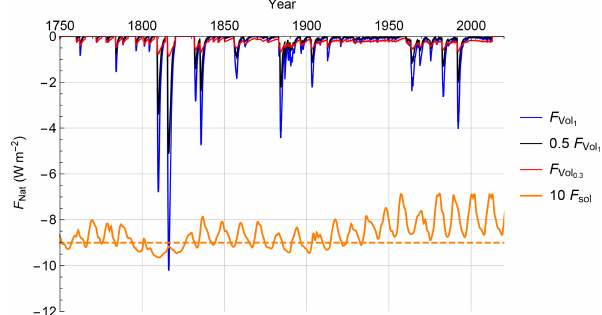
(blue) is shown alongside two Figure 2. Volcanic forcing F Vol 1 transformed versions: linearly damped by a constant 0.5 coefficient (black) and non-linearly transformed using Eq. (11) with ν = 0 . 3 (red). The solar forcing F Sol (orange) has been shifted down by − 9 and amplified by a factor of 10 for clarity. The figure has been adapted from Hébert et al.